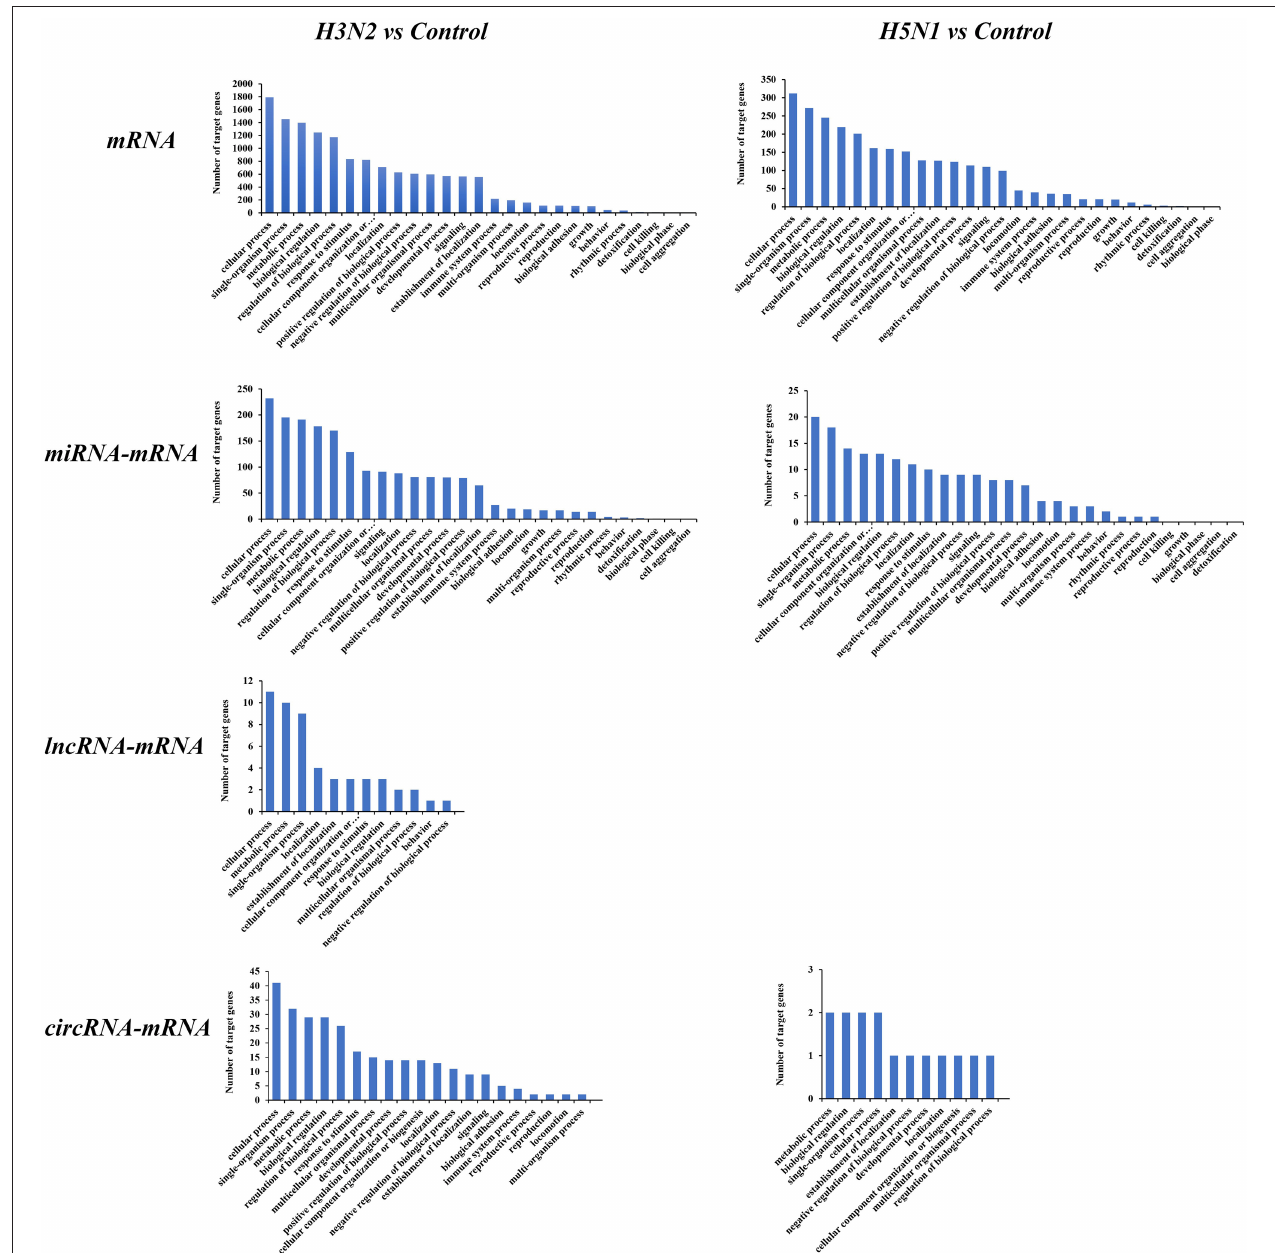
FIGURE 4 | GO pathways of differentially expressed mRNAs and target genes of differentially expressed miRNAs, lncRNAs, and circRNAs. The horizontal axis shows the functional classification, and the vertical axis shows the number of genes in the classification. of cytokine and pathogen-host interaction pathways and